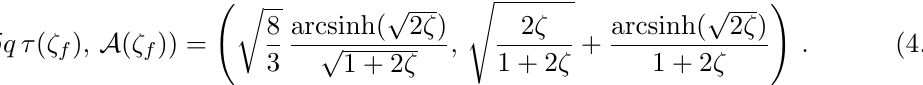
Figure 11. Left: entropy growth for d = 3 near extremal RN black holes. The data points are for (cid:14)q = 1 , while the solid curve is (4.35). The red dashed line has slope 2 v E , where v E = 10 as given in (3.14). Note that time has been rescaled by (cid:14)q . The curve is extremely straight and saturation happens parametrically later than the lower bound given in (1.12), as v B = Right: entropy growth for a large d Schwarzschild black hole. The data points are for d = 20 and the solid curve is (4.36). Note that time has been rescaled by d , hence the curve has (cid:12)nite initial slope, but saturation takes in(cid:12)nitely long (in rescaled time). In unscaled time t S = p 2 R + O (1 =d